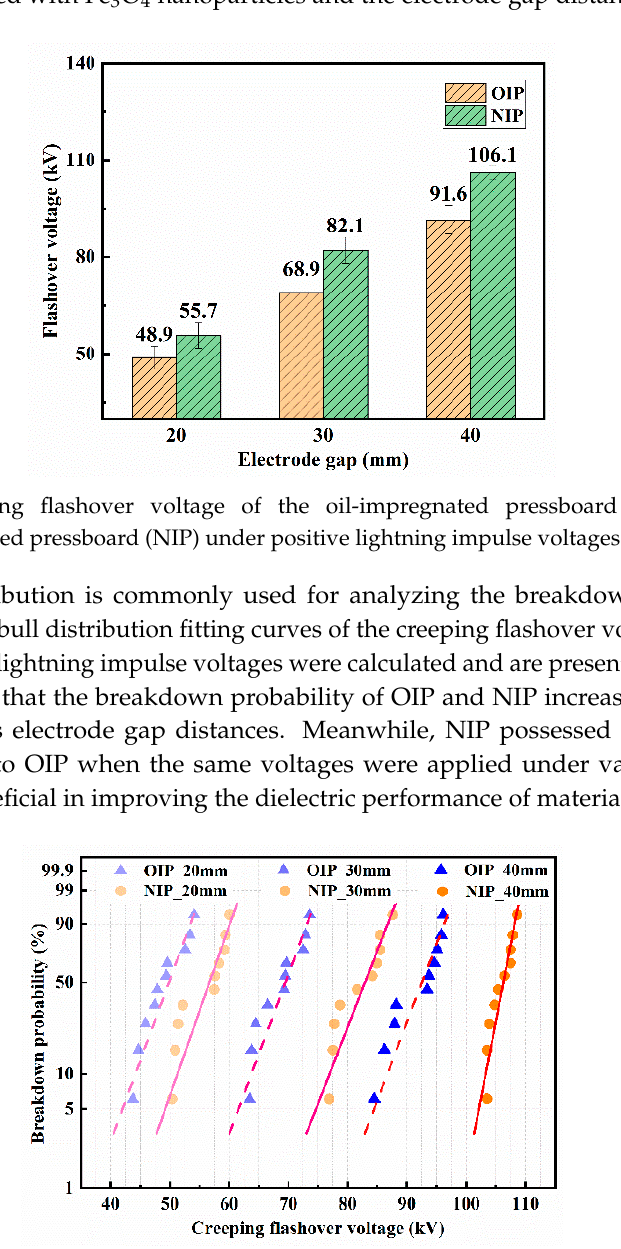
Figure 6. The Weibull distribution fitting curves of the creeping flashover voltages under positive lightning impulse voltages.